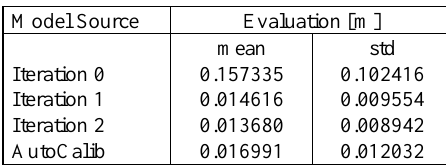
Table 1. Evaluation statistics of 3D reconstruction in different steps and methods